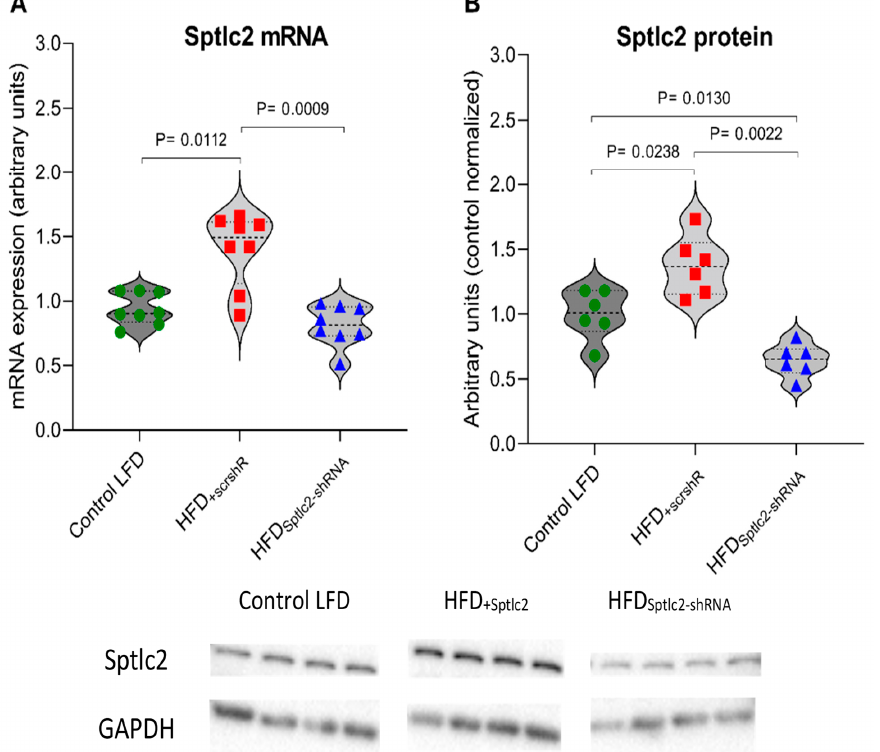
Figure 2. ( A – B ) Expression of skeletal muscle Sptlc2 at the ( A ) mRNA ( n = 8) and ( B ) protein level ( n = 6). Significance by Mann–Whitney U test. The figures show the median and interquartile range. The observed molecular weights of indicated proteins are different from the theoretical values, as stated by the antibody manufacturer. Green circles - values for individual Control LTD gastrocnemius muscles; Red squares - values for individual HFD +scrshRNA gastrocnemius muscles; Blue triangles - values for individual HFD Sptlc2-shRNA gastrocnemius muscles.